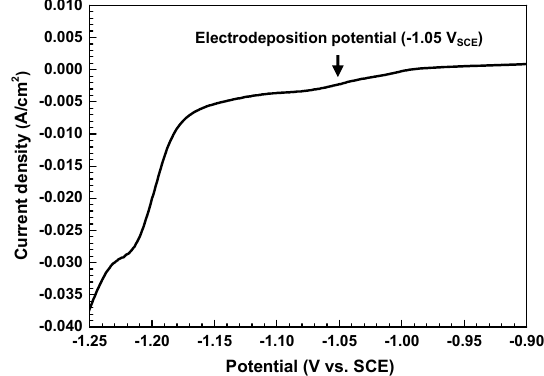
Figure 3. Linear sweep voltammogram of carbon steel substrate in Fe(III)–triethanolamine (TEA) solution at 80 °C.